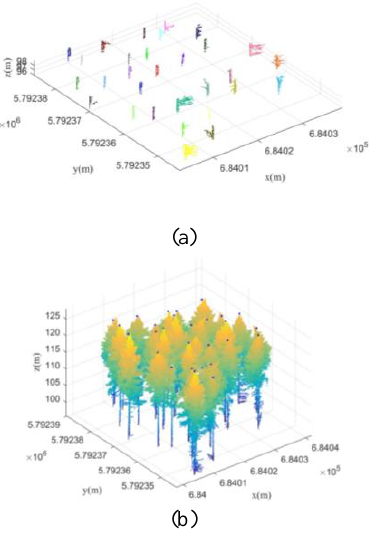
Figure 3. DBSCAN clustering results and the tree top findings. (a) The clustering results using the DBSCAN method; (b) The detected tree tops, which are labelled as blue points.